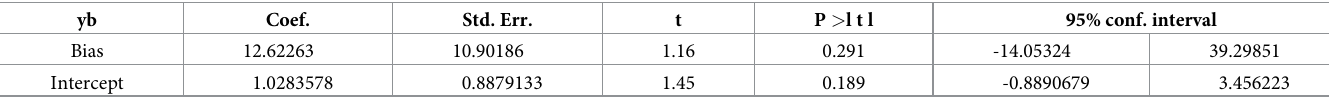
Table 2. Inferred by egger method that there is no publication bias(P-value = 0.291). yb Coef. Std. Err. t P > l t l 95% conf.